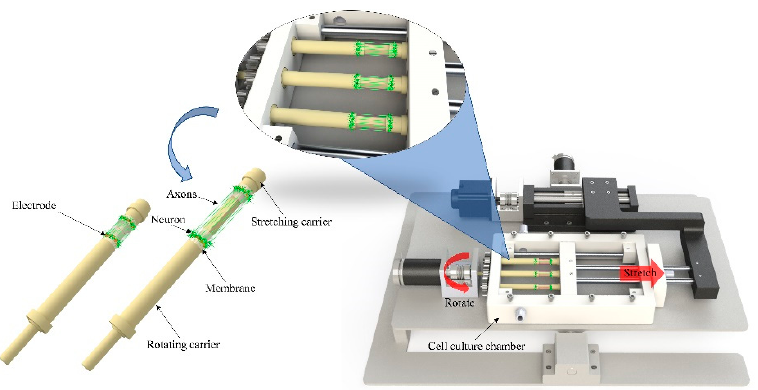
Figure 2. The working principle of the three-dimensional neural cell stretch growth device.